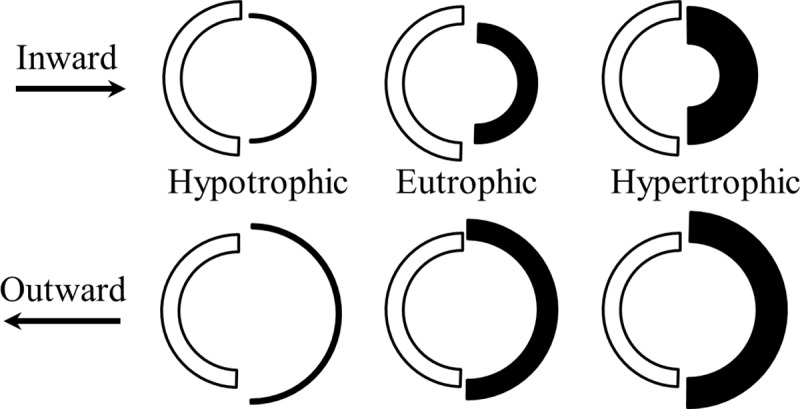
The descriptive conventional classification.The ‘inward’ or ‘outward’ means reduction or increase in lumen; the ‘hypertrophic,’ ‘eutrophic,’and ‘hypotrophic’ indicates increase, no change, or decrease in wall cross-sectional area, respectively.